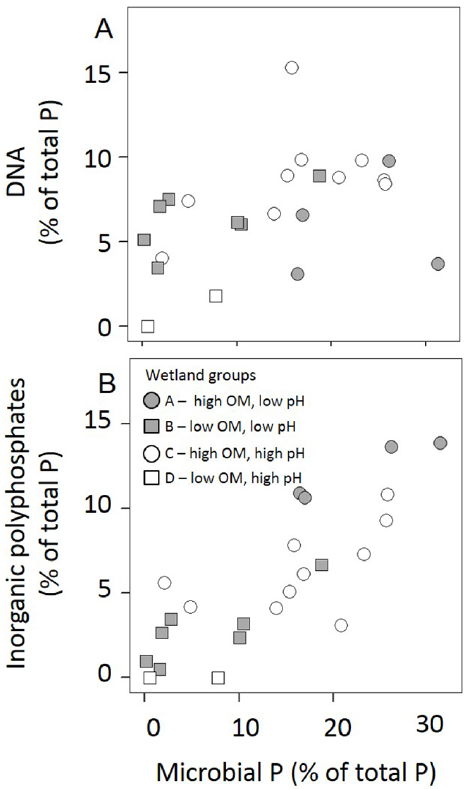
Figure 6. Plot of microbial P against (a) DNA and (b) total inor- ganic polyphosphates, both showing significant positive correlation as determined by Spearman’s rank correlation (rho ( DNA ) = 0 . 66, p < 0 . 01, rho ( total inorganic polyphosphates ) = 0 . 78, p < 0 .